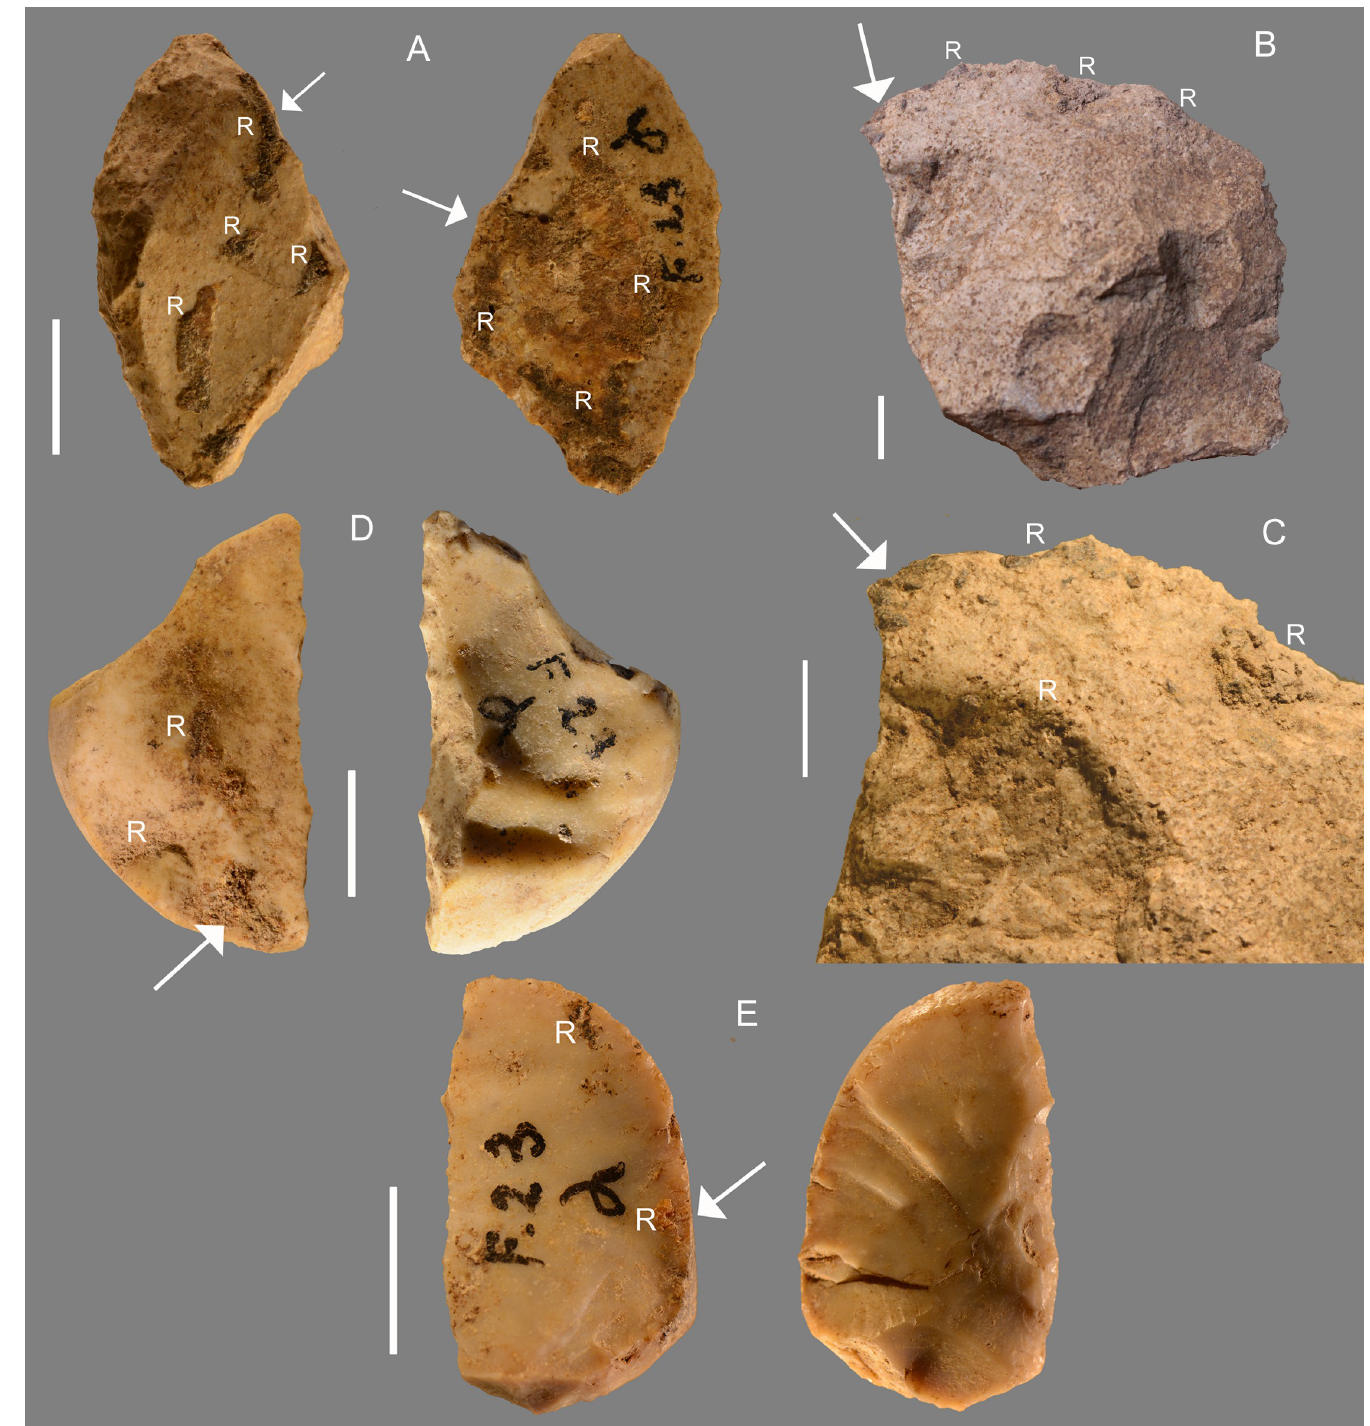
Fig 4. Grotta del Fossellone, layer 23 alpha. Stone tools with analyzed residue . The white arrow indicates the analyzed sample; R indicates macroscopically visible residue. All of flint except (B). (A) F1, side scraper. (B) F4, unretouched flake, silicified limestone, oriented according to the debitage axis; (C) detail of F4. (D) F5, transverse scraper, oriented according to the morphological axis; (E) F3, side scraper. Significant molecular markers of organic materials were found in all these pieces. Four other artifacts that gave no significant results are illustrated in Fig P in S2 File. Scale bar = 1 cm.